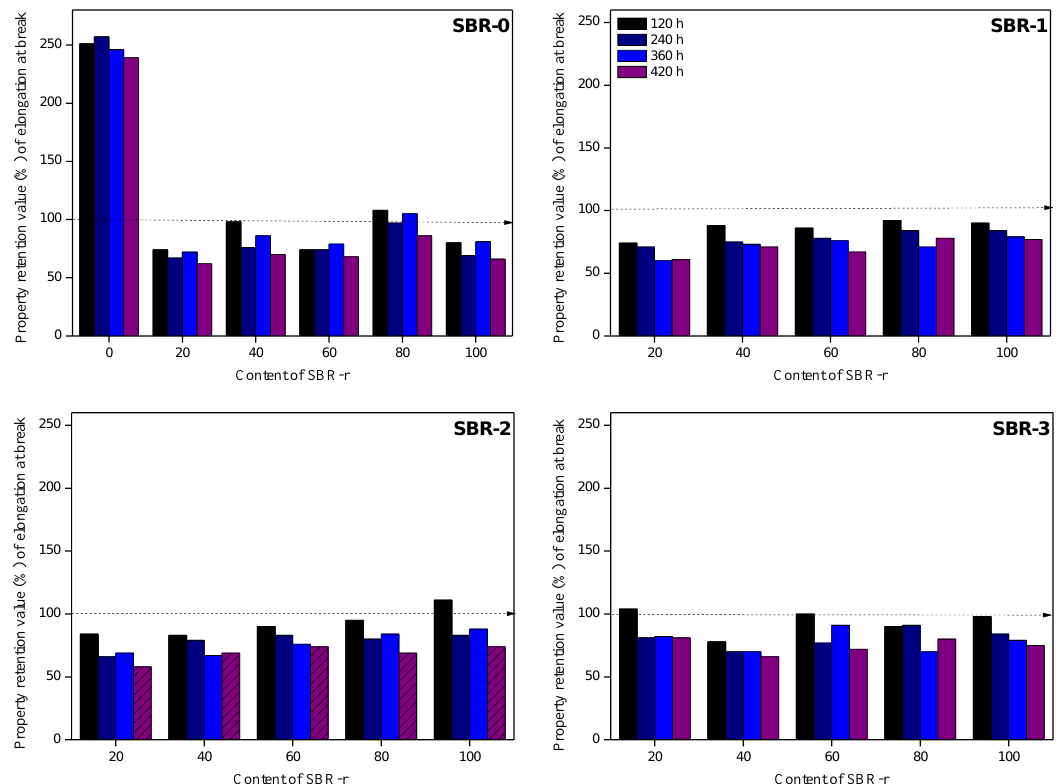
Figure 6. Property retention values (%) of elongation at break of the SBR-r composites after the aging in a UV chamber.